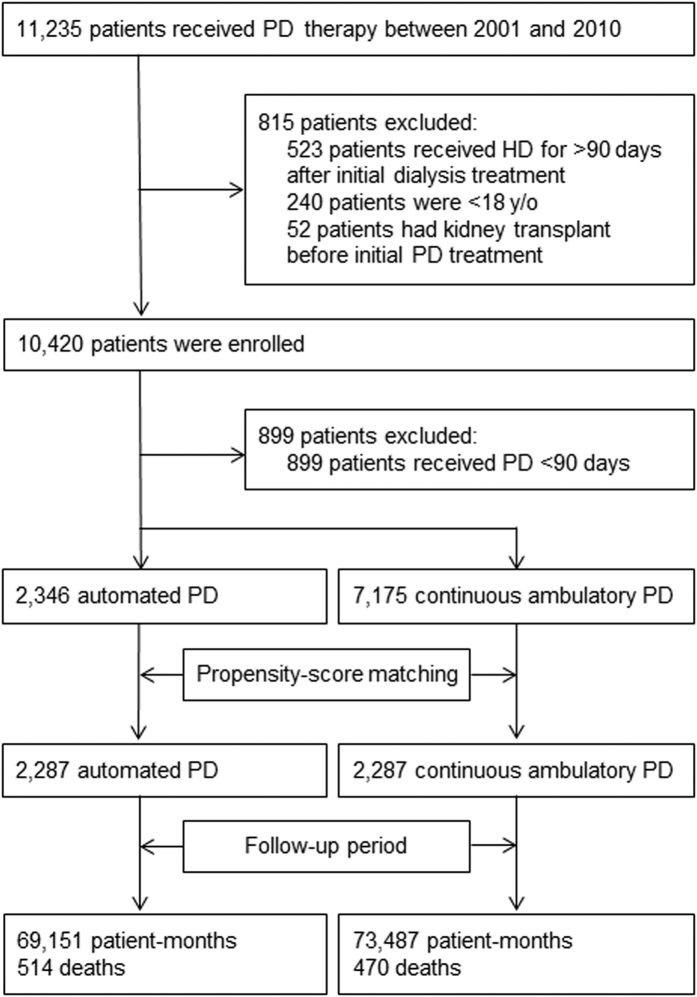
Enrollment of study participants.